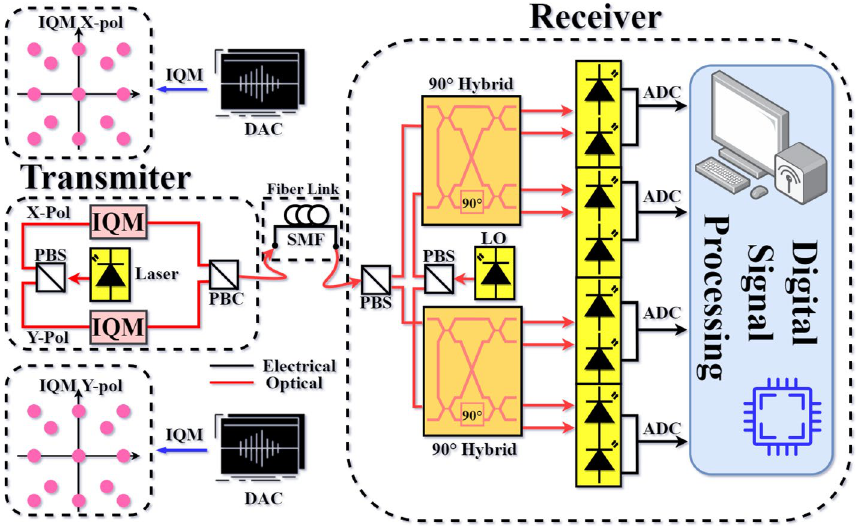
Fig. 4 32-Point 6PolSK-QPSK transmission system (transmitter, fiber link and